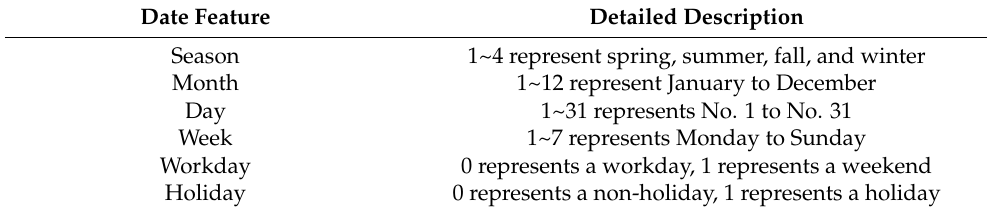
Table 2. Date feature